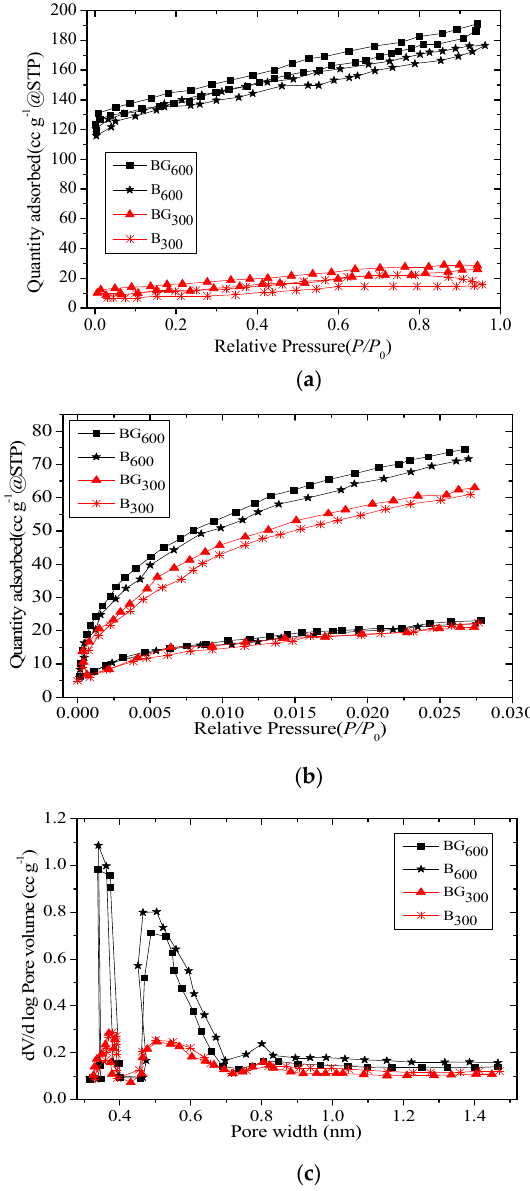
Figure 4. The adsorption-desorption curves and pore size distribution curves of biochar and BG composites based on N 2 and CO 2. ( a ) N 2; ( b ) CO 2; ( c ) Pole distribution curve.